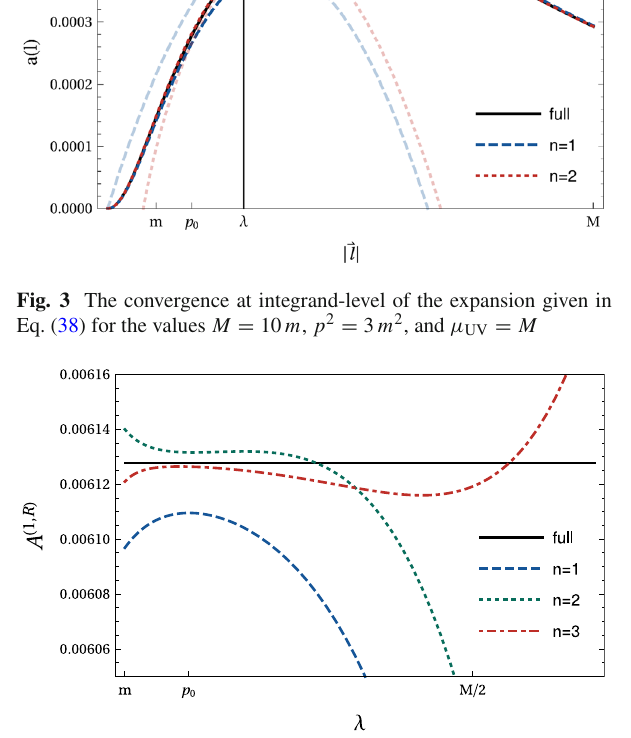
Fig. 4 Theconvergenceoftheintegratedresultsoftheexpansiongiven in Eq. (38) for the values M = 10 m , p 2 = 3 m 2 , and μ UV = M